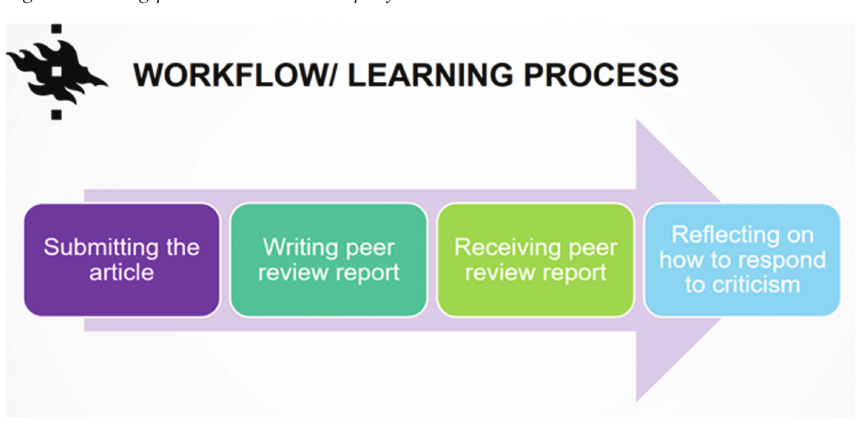
Fig. 2: Learning process in the Editori